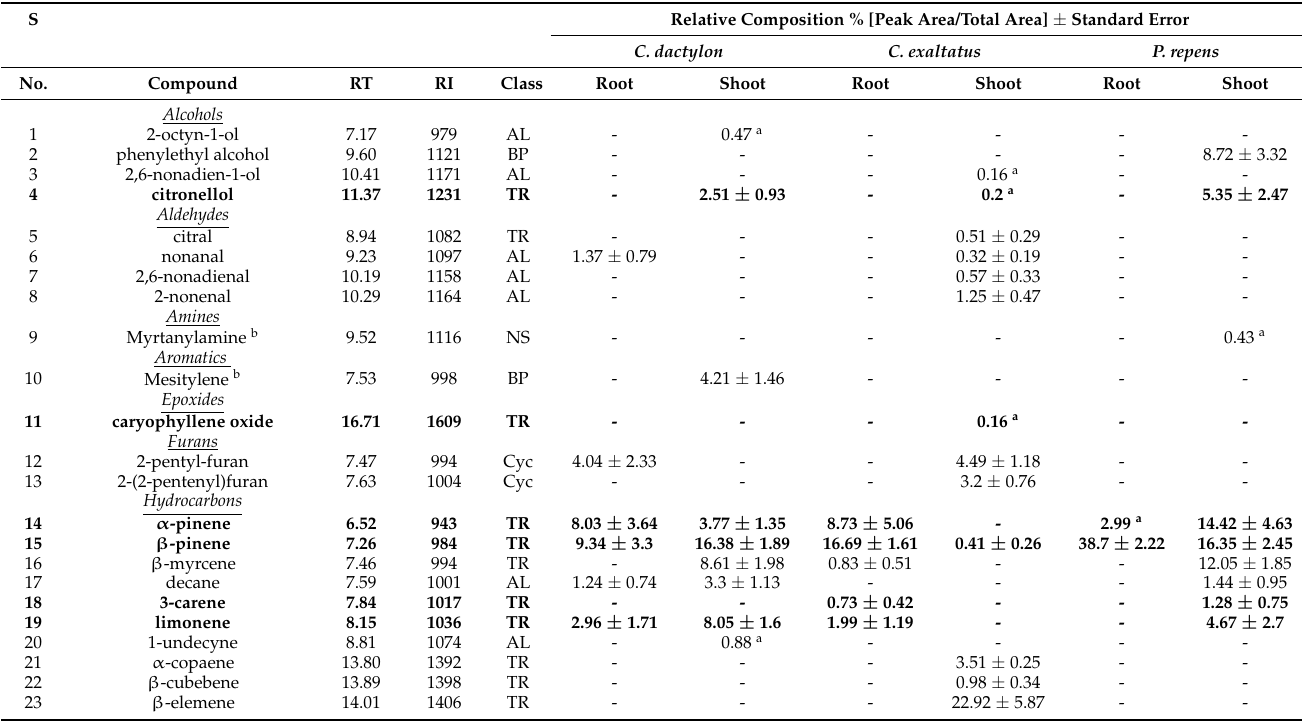
Table 1. Volatile compounds detected in the shoots and root parts of the graminoid plants C. dactylon , C. exaltatus , and P. repens . S Relative Composition % [Peak Area/Total Area] ± Standard Error C.